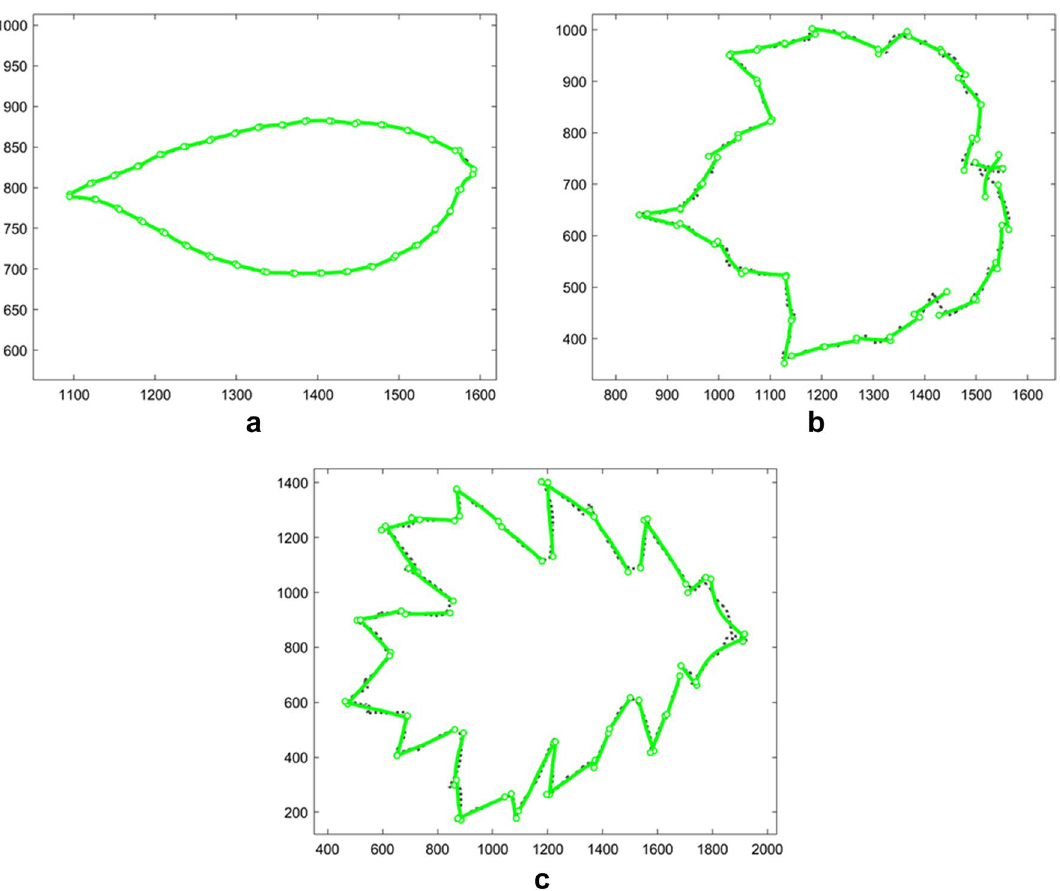
Figure 10. The fitting results of 145 leaves. ( a ) The best match (the 62nd profile—hickory, ˜ E 62 = 0.8748 ); ( b ) The average match (the 88th profile—red maple, ˜ E 88 = 4.0866 ); c The worst match (the 110th profile—red oak, ˜ E 107 = 9.7866